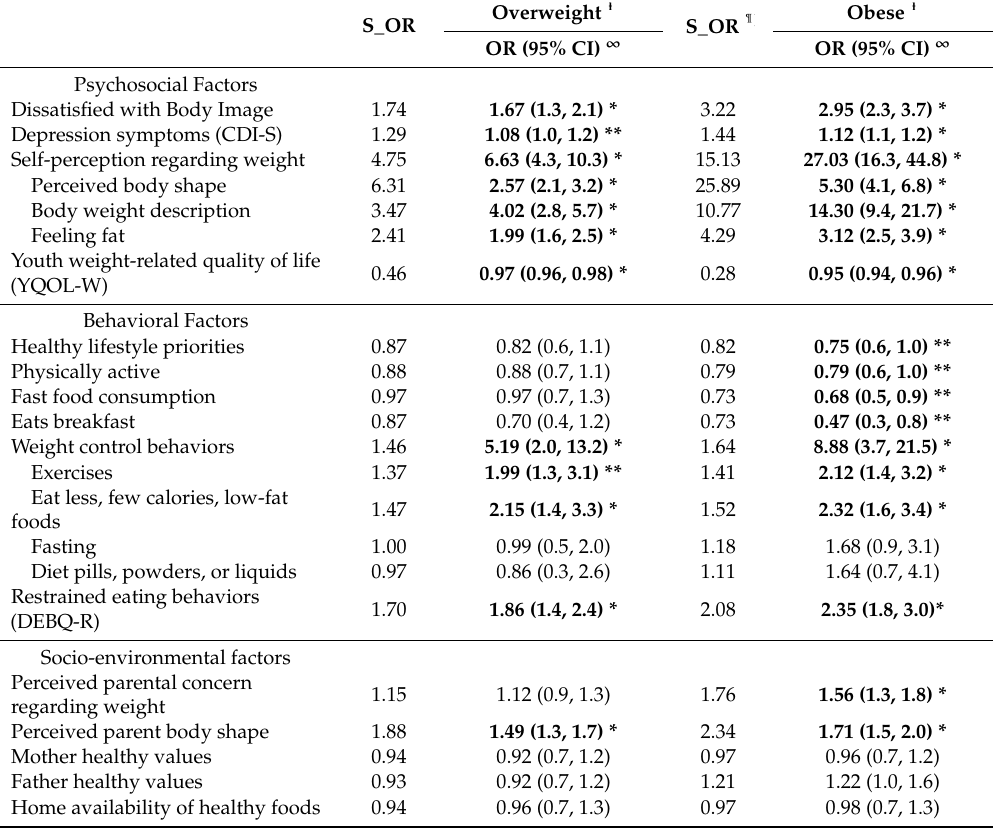
Table 4. Standardized and adjusted odds ratios for psychosocial, behavioral, and socio-environmental factors by BMI status, among youth in Mexico and the US ( n = 633). Table 2. Comparison of various psychosocial, behavioral, and socio-environmental factors by BMI category among youths in Mexico ( n = 181).